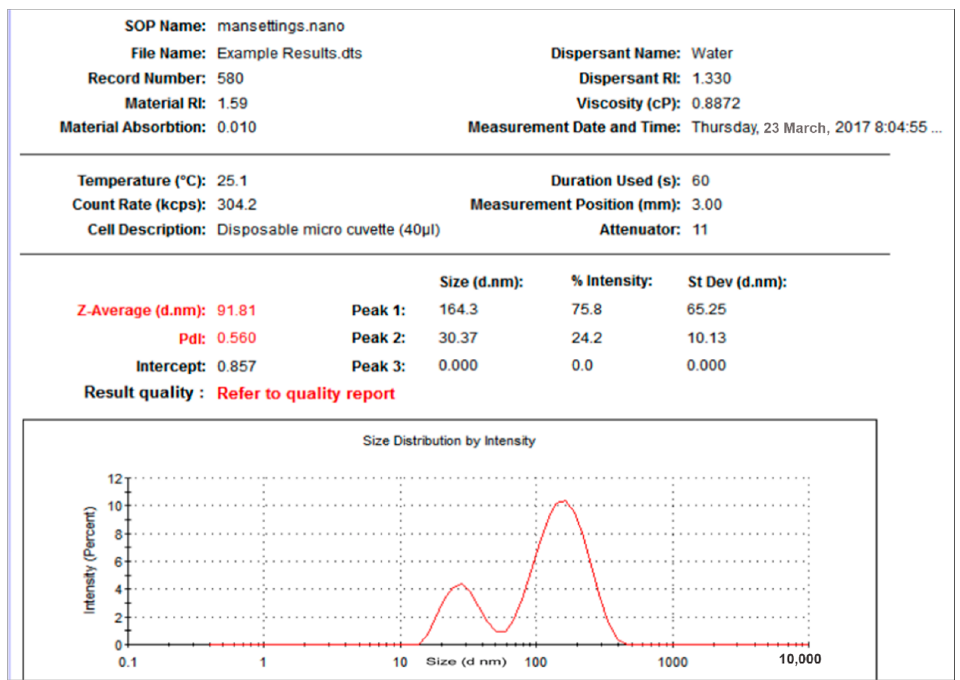
Figure 1. Size distribution of AgNPs capped with the biomolecules from O. forsskalii.